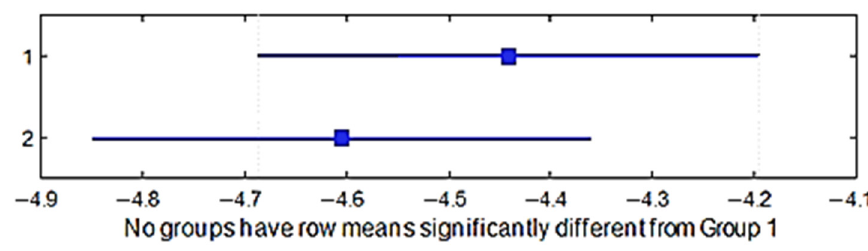
Figure 11. Confidence intervals of the shrinkage in the warp direction of different raw materials.